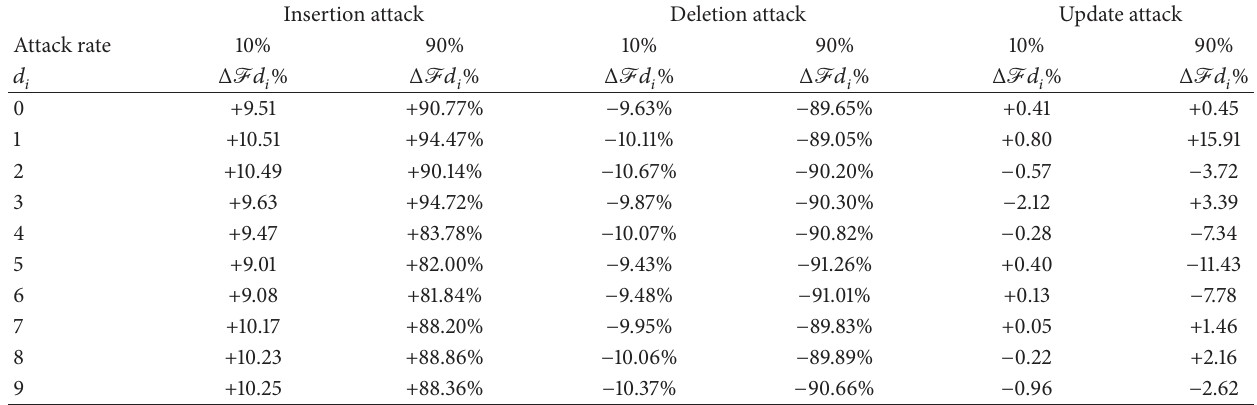
Table 9: Characterization of malicious modifications on digit frequency.